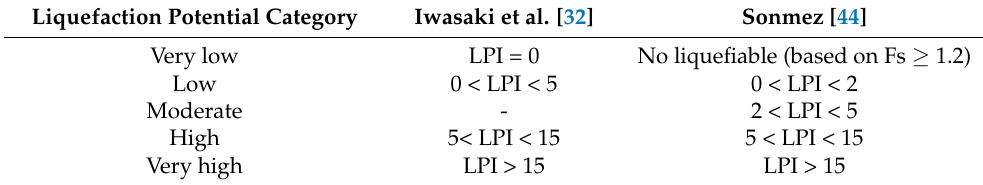
Table 5. Liquefaction severity in the LPI scale.